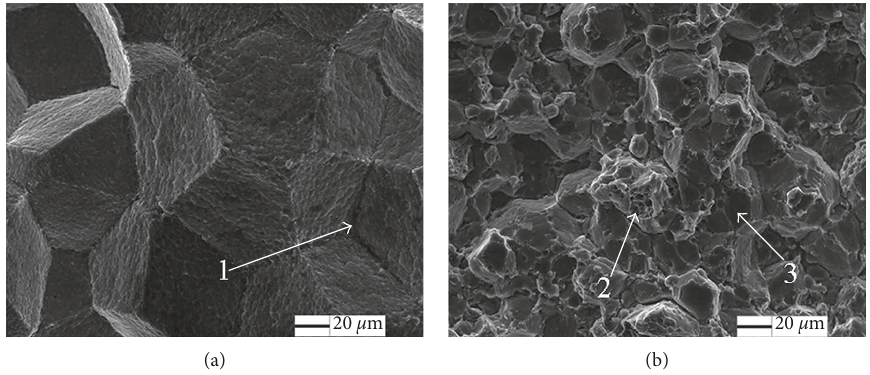
Figure 4: The fracture morphologies of the powder compacts 1 and 2 (a) and 3